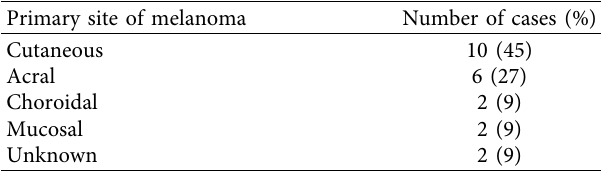
Table 1: Primary site.